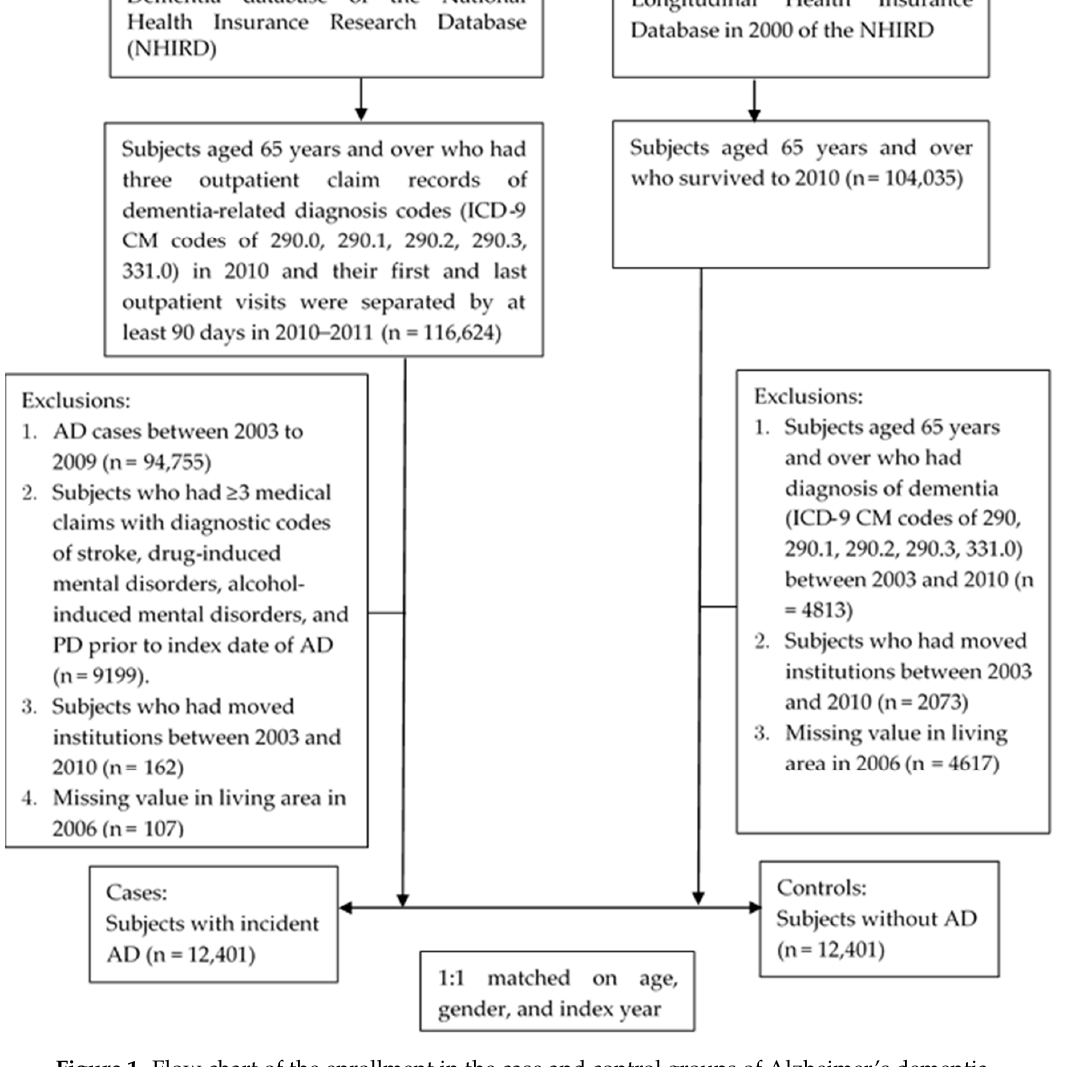
Figure 1. Flow chart of the enrollment in the case and control groups of Alzheimer's dementia.